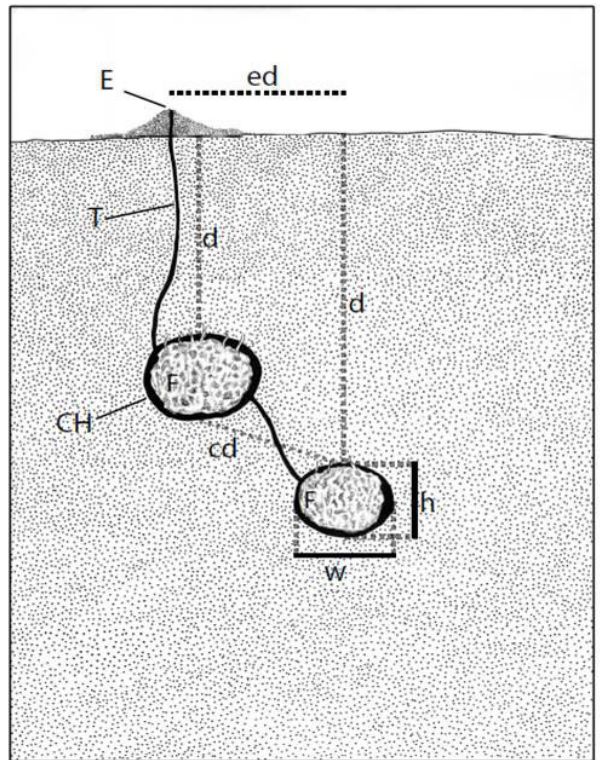
Fig 4. Cutaway view of a subterranean fungus-farming ant nest indicating standardized measurements. E = nest entrance; T = tunnel; CH = chamber; F = fungus garden; d = chamber depth; w = chamber width; h = chamber height; cd = distance between chambers; ed = offset distance from the entrance (measured for chambers that are not directly below the nest